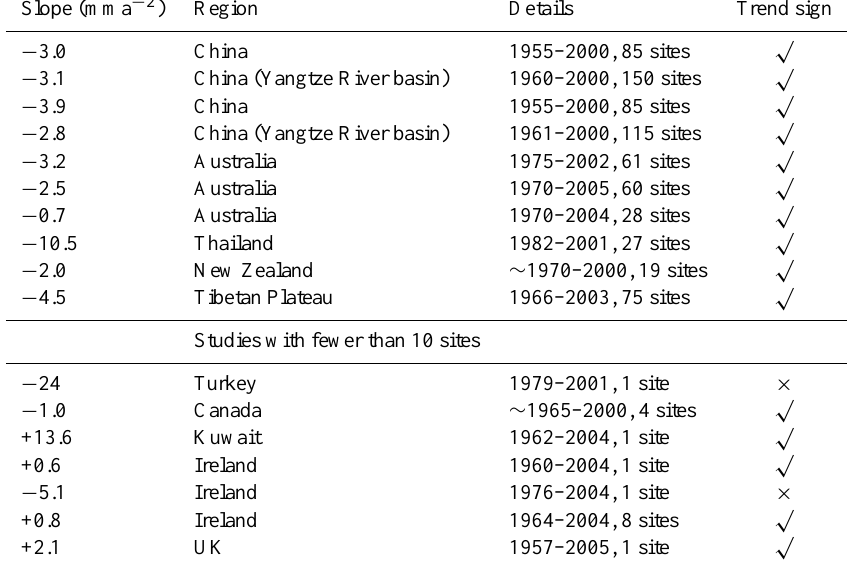
Table 3. Qualitative comparison of pan evaporation trends from Table 1 of Roderick et al. (2009) with E p trends from our study. The first √ column has units of mma − 1 a − 1 . “ ” in the last column means that the model reproduces the sign of the observed trend, while “ × ” means the